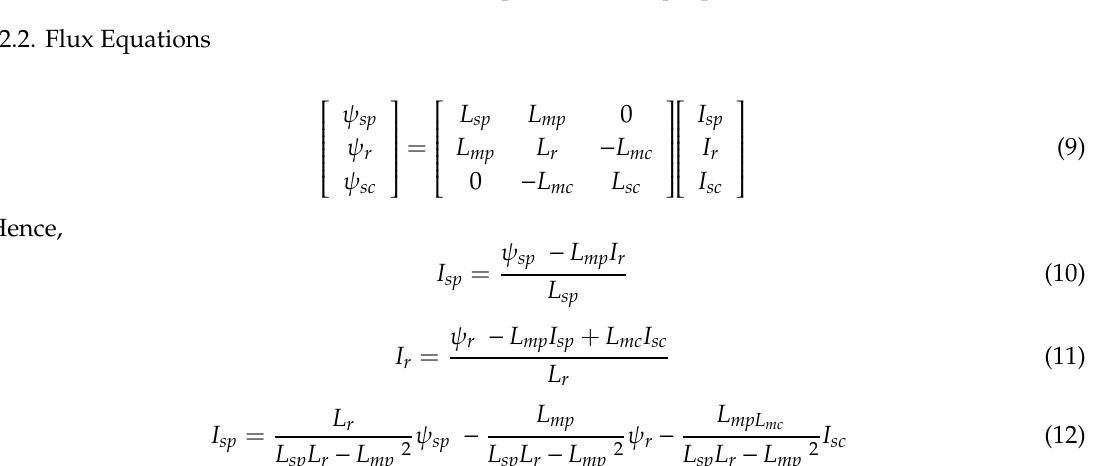
Figure 3. BDFTIG equivalent circuit per